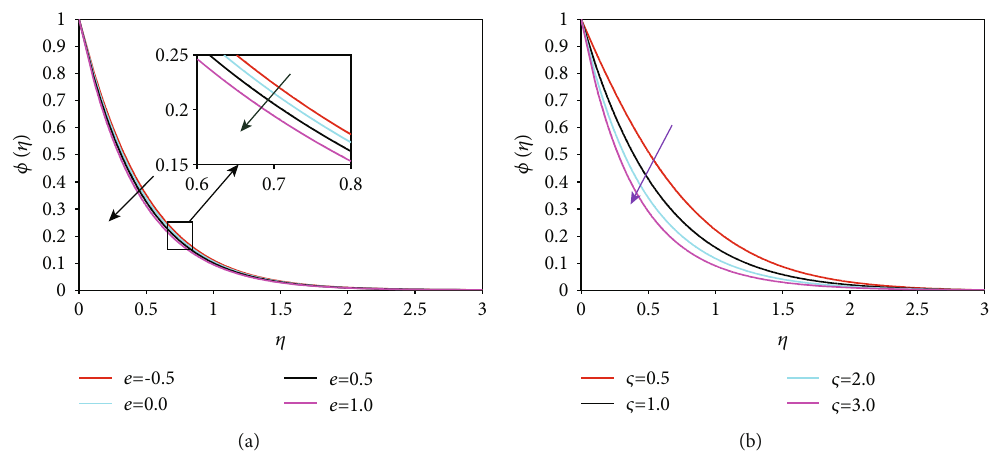
Figure 13: The graph of concentration for di ff erent values of fi tted rate constant ( e ) and concentration exponent ς .